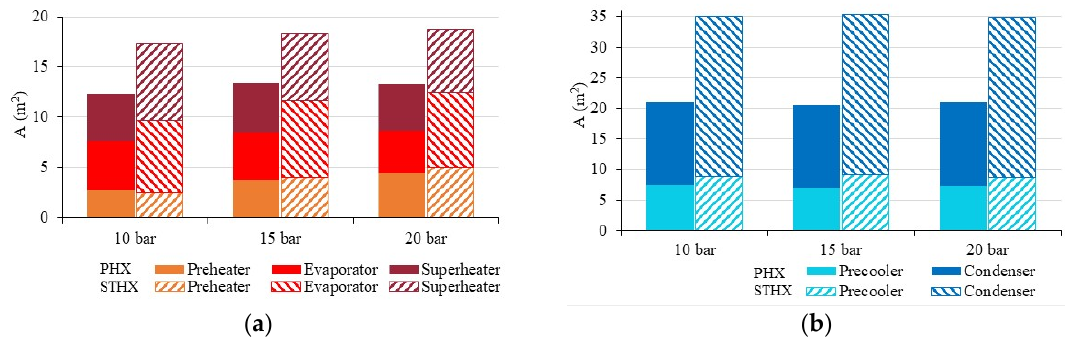
Figure 7. Heat transfer surface area for the ( a ) hot and ( b ) cold end.